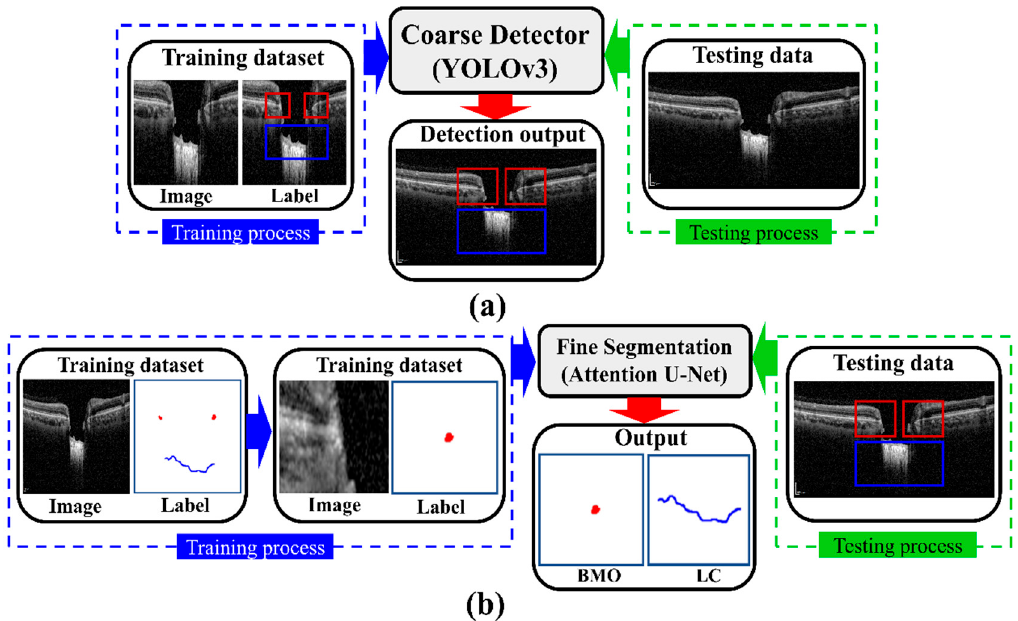
Figure 5. Block diagram of the proposed two-stage DL models: ( a ) the detection model with training and testing process, where the direction of blue, red, and green arrows indicate the working mechanism; ( b ) the segmentation model with training and testing process, where the direction of blue, red, and green arrows indicate the working mechanism.